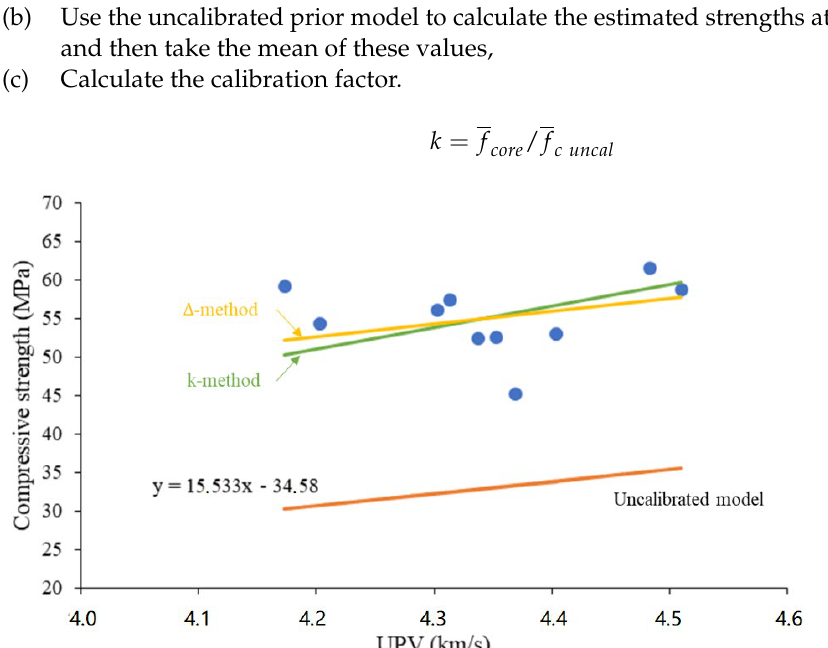
Figure 2. Scatter diagram of the (x, f core ) pairs with models obtained by the calibration approach.